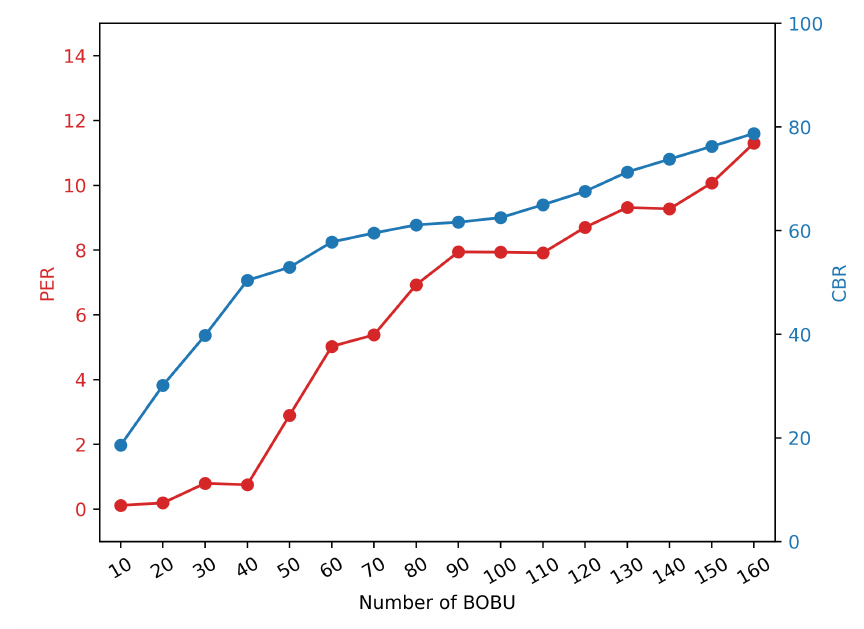
Figure 25. Comparison of CBR and PER with 10-160 BOBU.